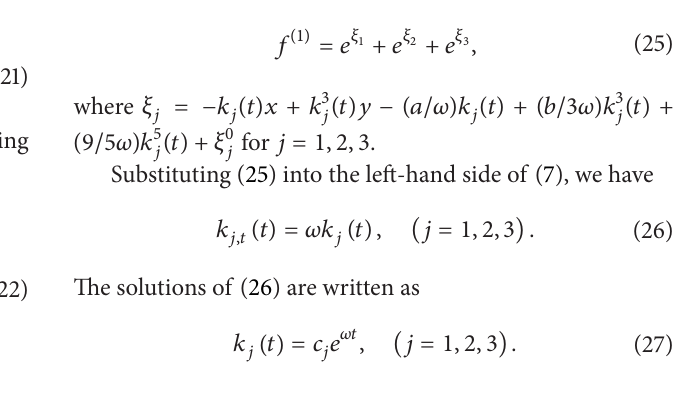
From (20), we might assume that the relations 𝑒 𝜃 12 = 𝐹(𝑡) .